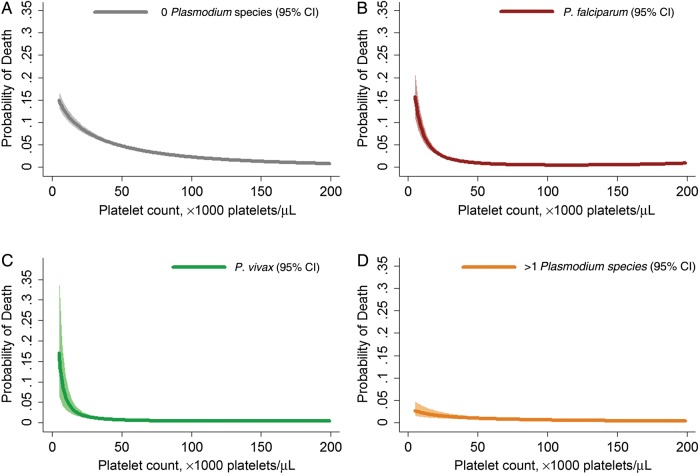
Estimated probability of mortality, by platelet count. Figures were generated by multiple fractional polynomial regression analyses (with adjustment for age, sex, ethnic group, and year), according to infecting Plasmodium species, as follows: 0 Plasmodium species (negative test results; A), P. falciparum (B), P. vivax (C), and >1 Plasmodium species (mixed infection; D). Abbreviation: CI, confidence interval.